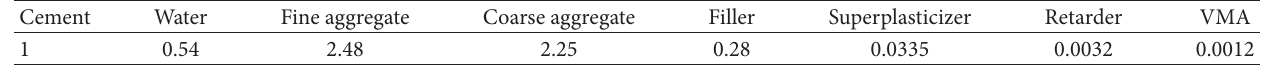
T 4: Mix design proportions for casting one cubic meter of